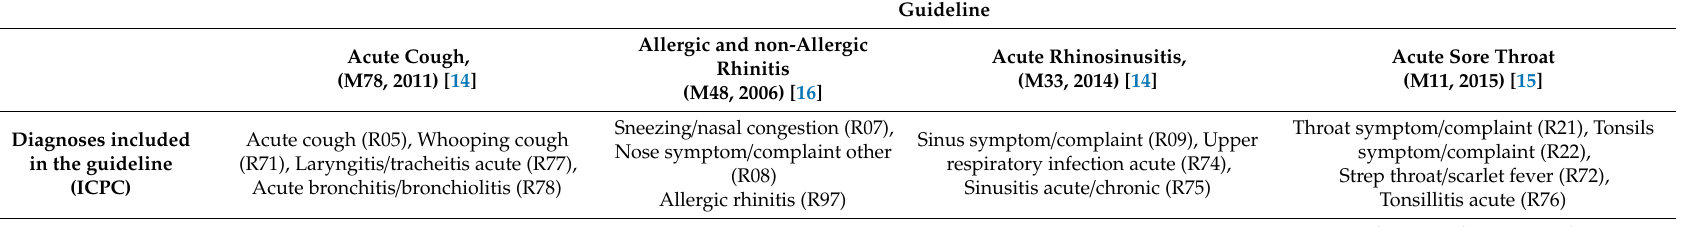
Table 1. Recommendations for prescribing of antibiotics for acute cough, allergic and non-allergic rhinitis, acute rhinosinusitis and acute sore throat and study